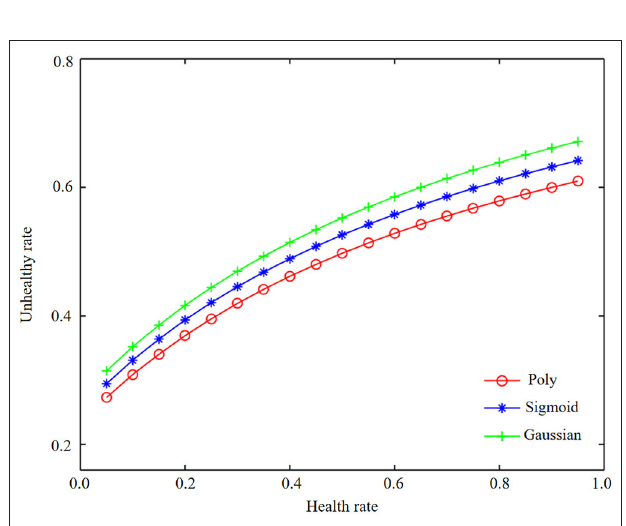
FIGURE 9 | The ROC curve representation of three kernel functions under machine learning combined